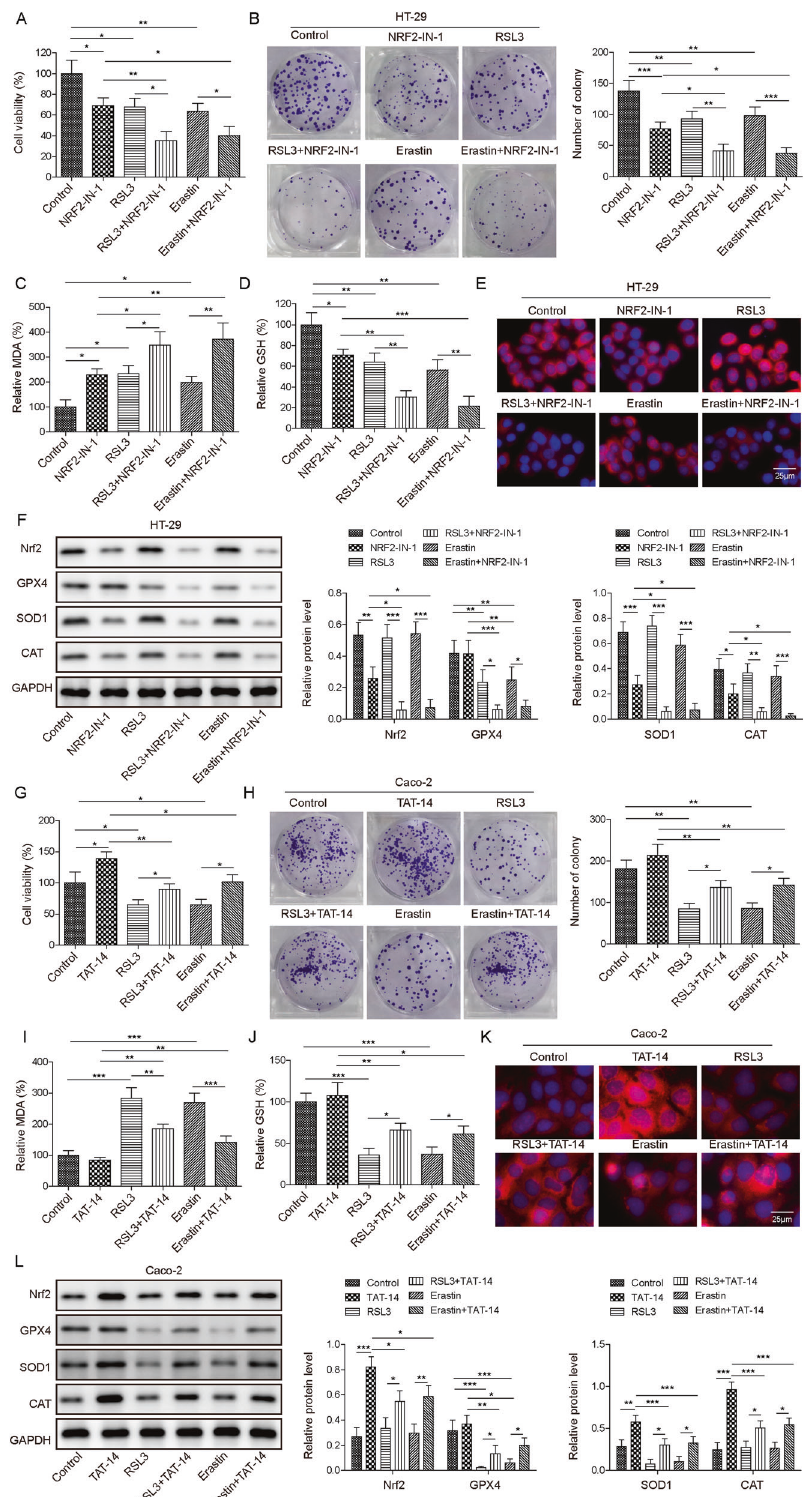
GSH level in HT-29 cells in comparison to the treatment of RSL3 or Erastin alone (Fig. 3C, D). The NRF2-IN-1 treatment signi fi cantly reduced Nrf2 expression as indicated by IF fi gures and western blot results (Fig. 3E, F); in addition, the treatment of RSL3 or Erastin augmented the inhibitory effect of NRF2-IN-1 on Nrf2